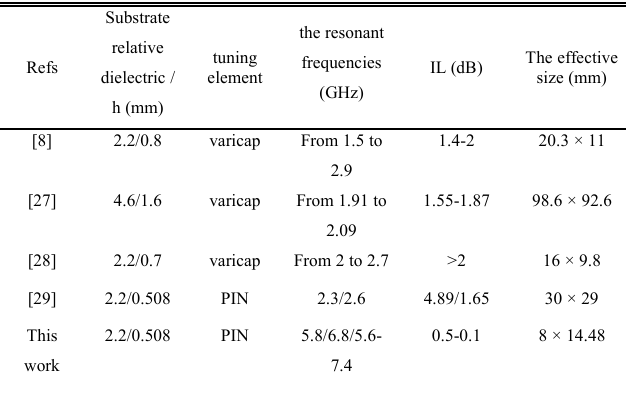
FIGURE 15. The effective refractive index of the reconfigurable filter in case of turning both diodes into ON states. The real and imaginary curves of the effective refractive index have a negative sign around both of the resonant frequencies as display in fig. 15. Therefore, this design has kept its metamaterials properties in the dual state (case 03). TABLE III. Comparison with other reported reconfigurable SIW based tunable band-pass